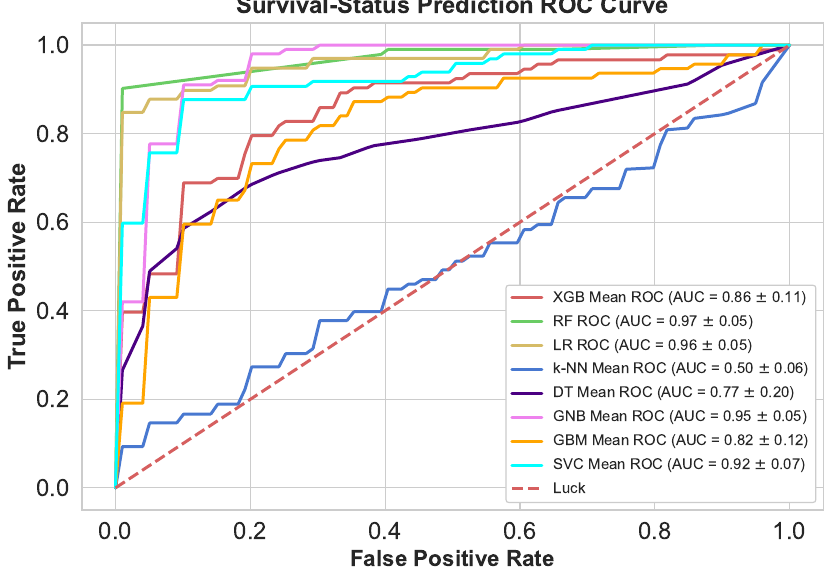
Figure 11. Survival Status classifier’s ROC’s at dynamic